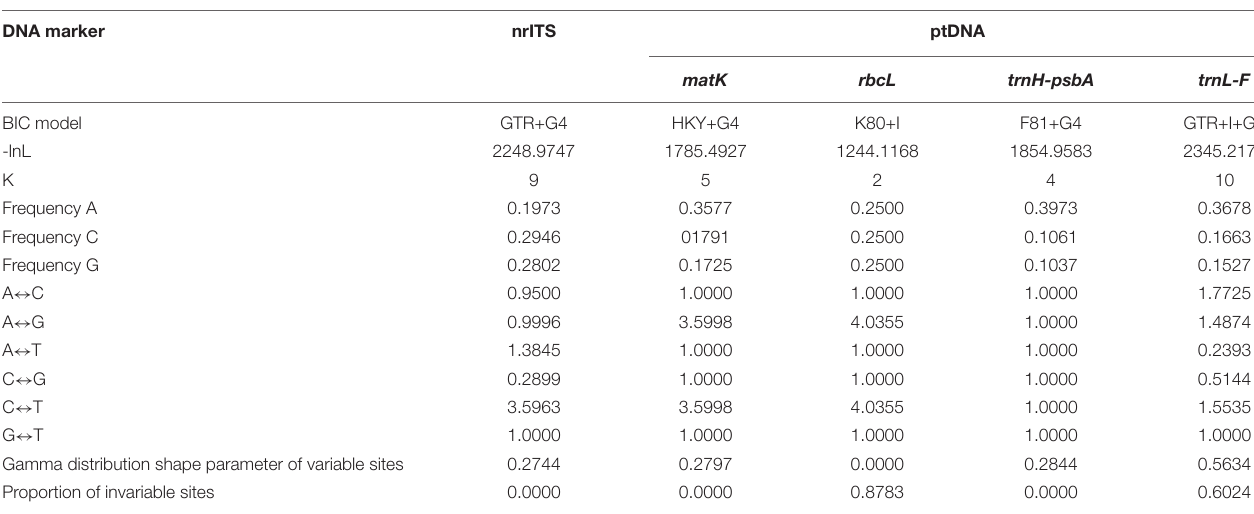
FIGURE 2 | A geographical sampling of the Pedicularis siphonantha complex from the Hengduan Mountains, southwestern China. The colors of circles correspond to different taxa. Numbers and letters indicate populations; these abbreviations are also used in Figures 3 , 4 , 6 . More information regarding collection vouchers can be found in Supplementary Table 1 . TABLE 1 | The best-fit model of partition dataset